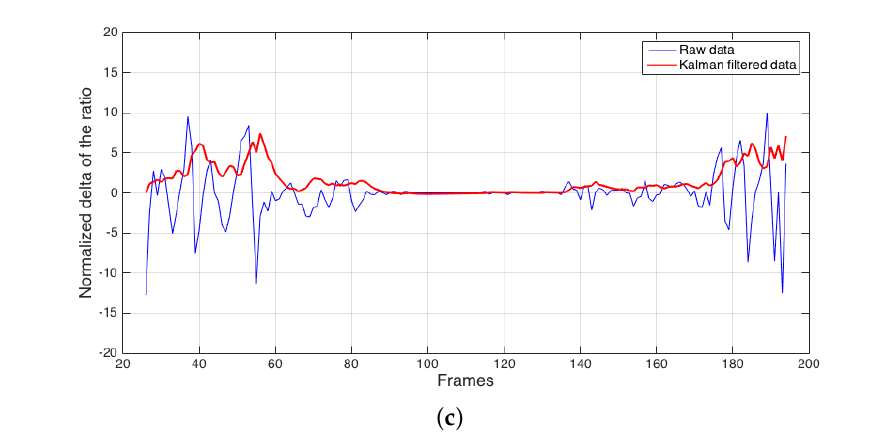
Figure 4. Example of fall occurring parallel to the camera. ( a ) ratio; ( b ) angle; ( c ) normalized delta of the ratio.